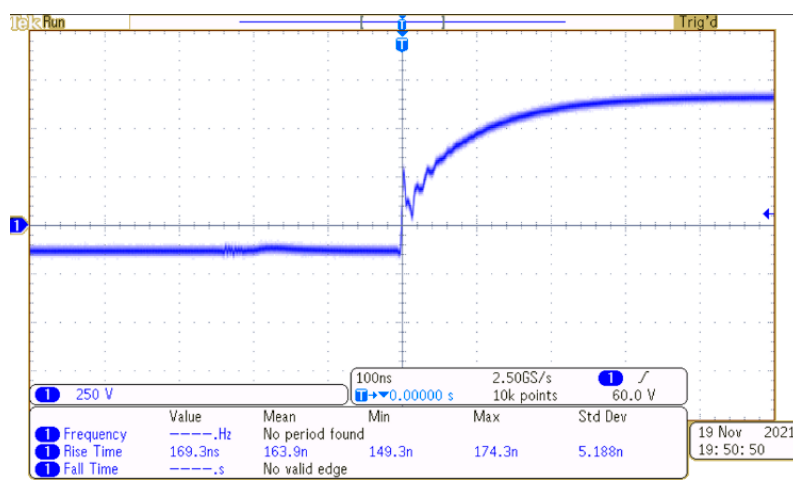
Figure 11. Gate—source voltage rise time for transistor SiC v2 (160 ns).